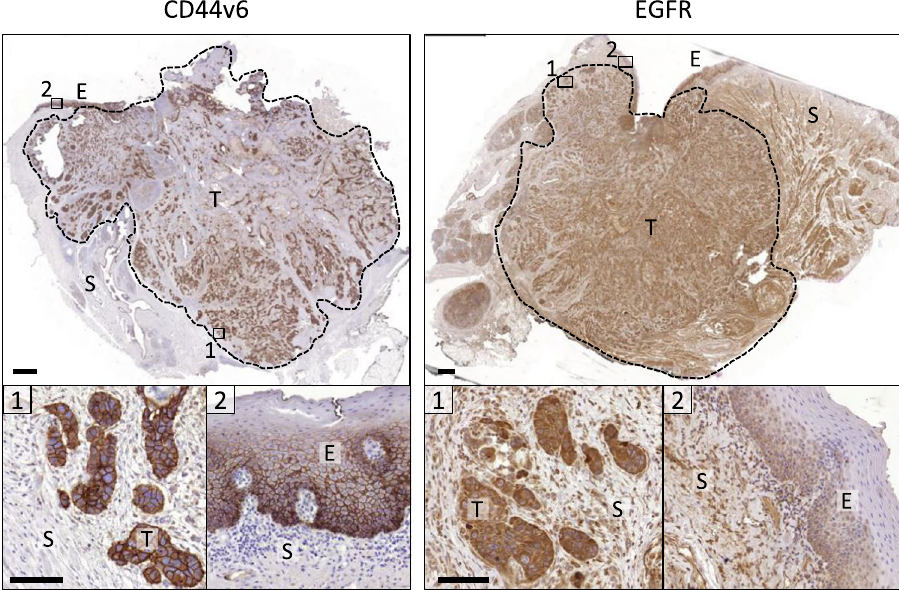
Figure 1. Expression of CD44v6 and EGFR in primary human HNSCC samples. Tumor (T), normal epithelium (E), stroma (S). Dotted lines mark the tumor edge. Representative samples from 7 (CD44v6) or 5 (EGFR) independent tumors. Scale bars indicate 1000 µ m (overview) and 100 µ m